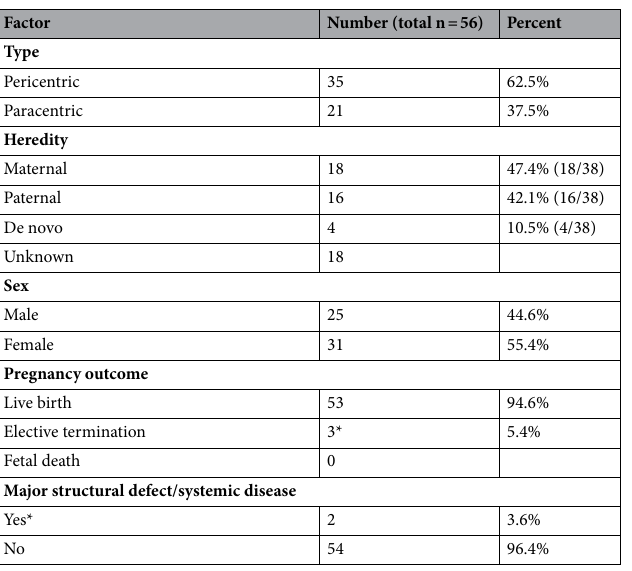
Table 3. Pregnancy outcomes associated with 56 cases of chromosomal inversion. *CNS defects in two and one thalassemia